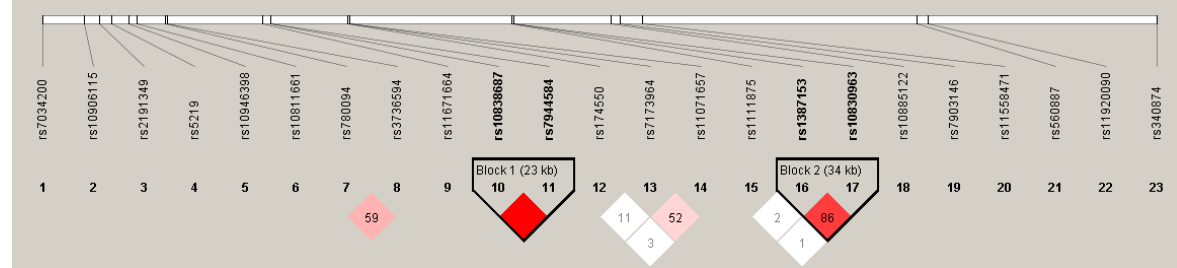
Figure 2. Linkage disequilibrium map of observed SNPs in the T2DM case